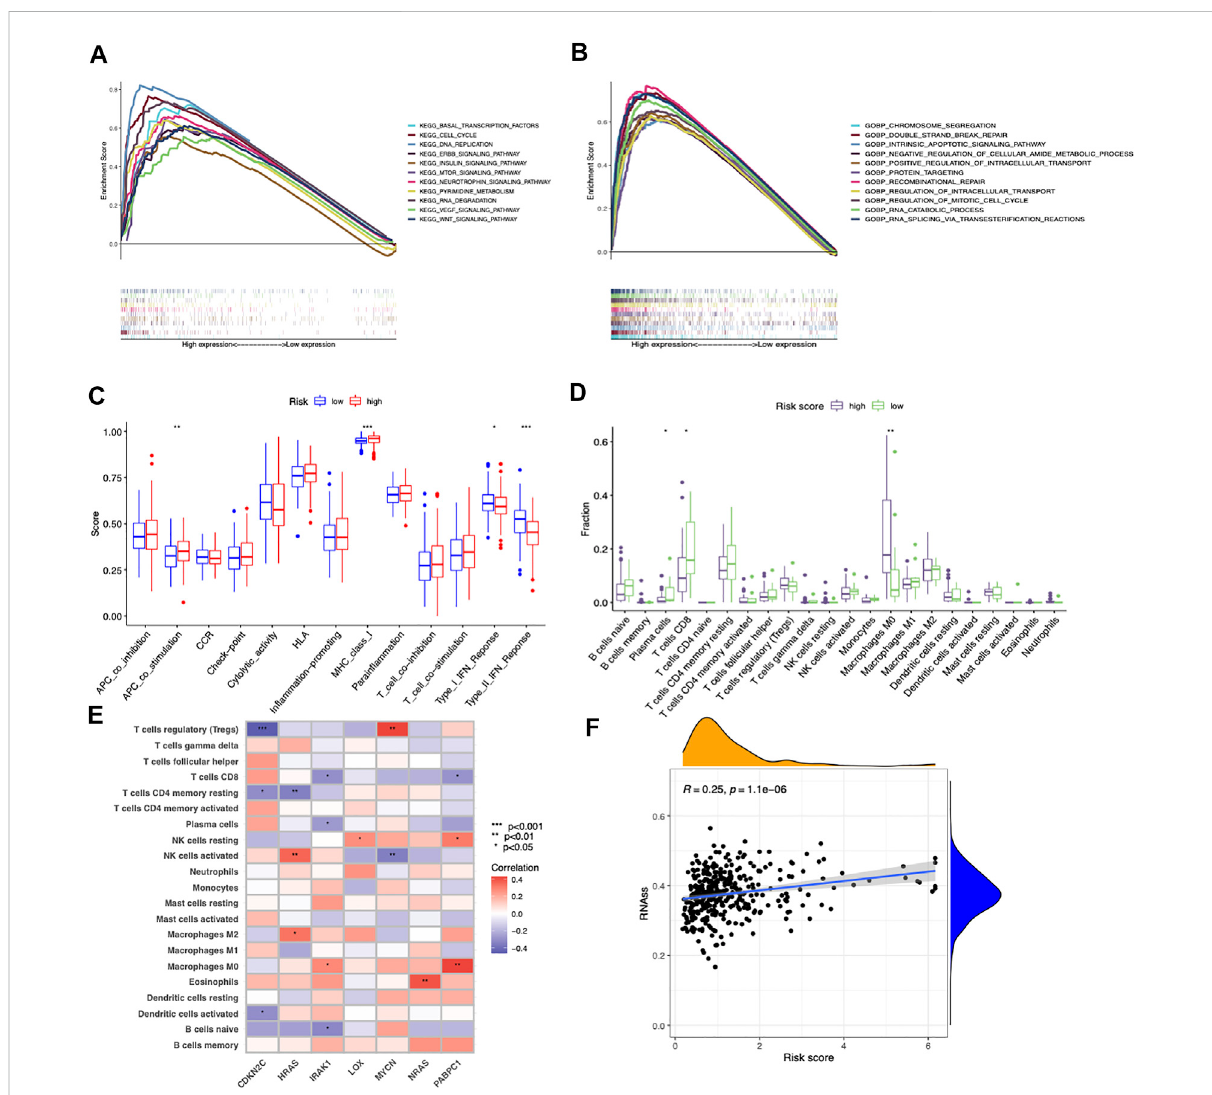
FIGURE 5 Different cancer hallmarks and tumor microenvironments between two risk score groups. (A,B) GSEA of signi fi cantly enriched pathways in the high-risk group based on KEGG and GO (biological process) gene sets. (C) Differences in the proportions of immune-related pathways between the low-andhigh-riskgroups. (D) Differencesintheimmunecellsin fi ltratedinthetumormicroenvironmentbetween thelow-andhigh-riskgroups. (E) Correlations between in fi ltrated immune cells and the seven prognostic-related cancer driver genes. (F) Correlation between risk score and cancer stemness score (RNAss) based on Spearman ’ s correlation